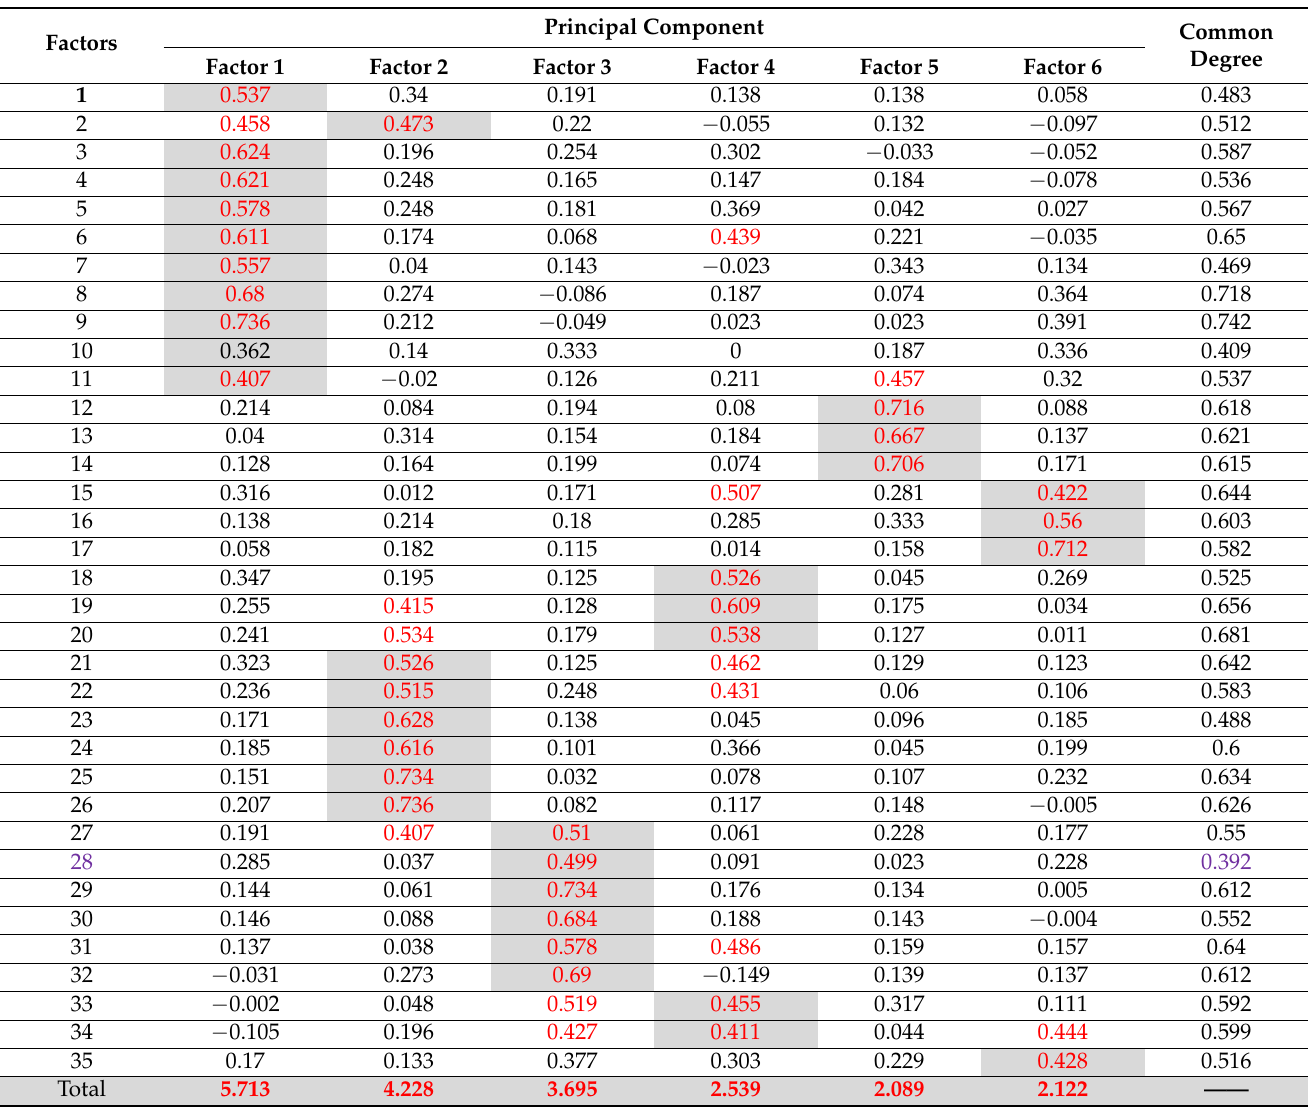
Table 2. The Rotated Component